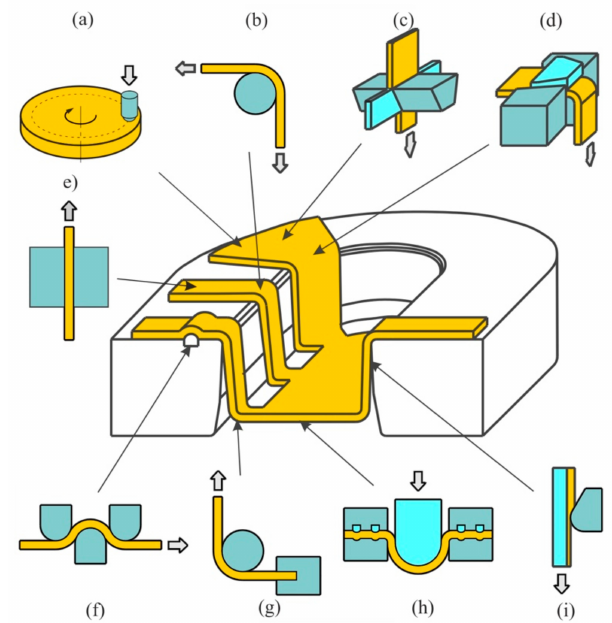
Figure 2. Tribological tests representing the friction conditions in the specific areas of the draw piece: ( a ) pin-on-disc tribometer, ( b ) bending under tension, ( c ) drawing with tangential compression, ( d ) bending with tangential compression, ( e ) strip-drawing test, ( f ) draw-bead test, ( g ) strip-tension test, ( h ) hemispherical stretching, ( i ) strip-reduction testing; prepared based on